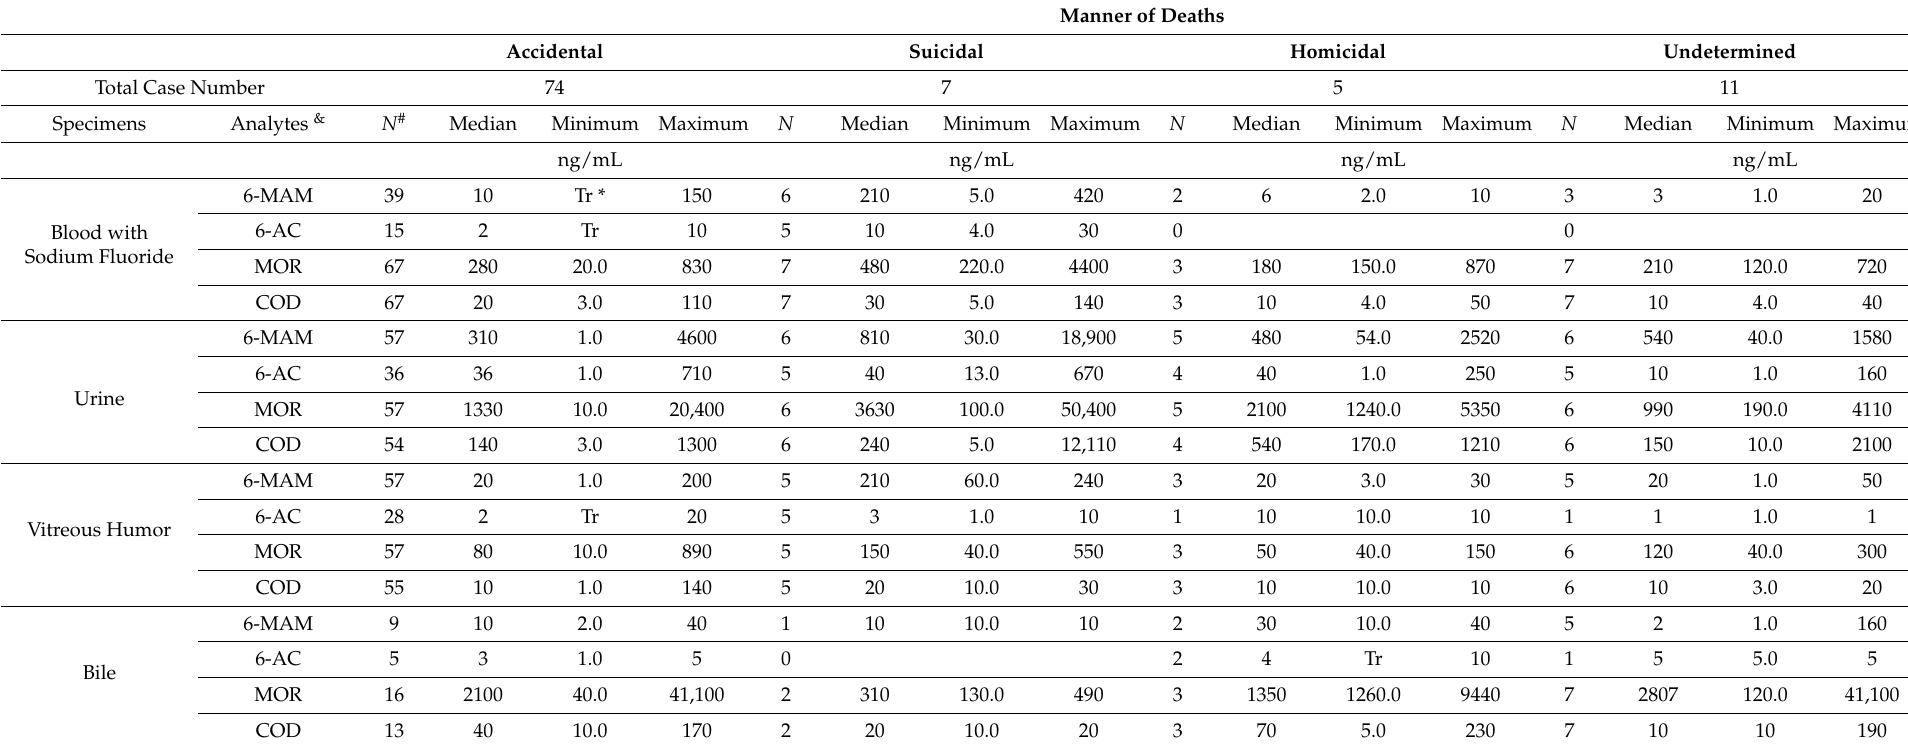
Table 4. Heroin biomarkers, morphine, and codeine concentration in relation to manner of death in the current